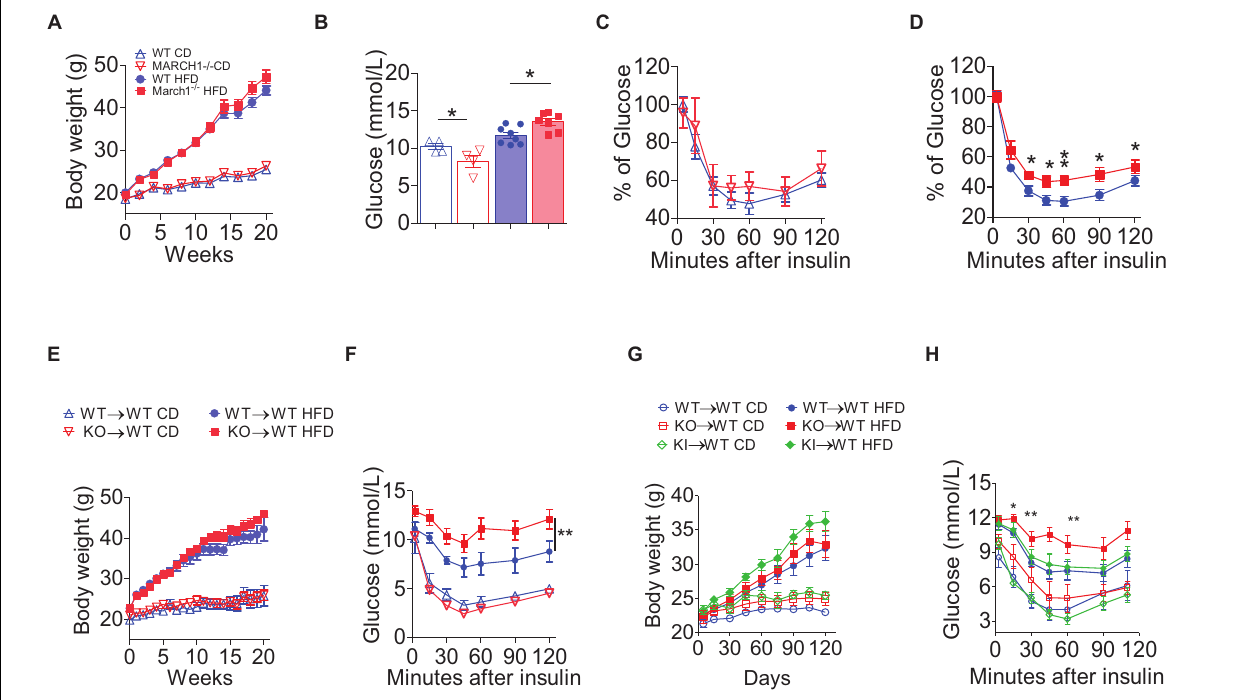
FIGURE 1 | March1 deficiency exacerbates obesity-induced insulin resistance. Mice were fed control diet (CD) or high-fat diet (HFD) and tested for fasting glucose and insulin tolerance (ITT). (A) Body weight gain, (B) fasting glucose, and (C,D) ITT of WT and March1 − / − mice after 20 weeks. (E–G) Six week old WT mice were lethally irradiated and received an i.v. injection of bone marrow cells from March1 − / − or WT mice. After 8 weeks of reconstitution, these WT BMC (WT → WT) and March1-/-BMC (KO → WT) were fed CD or HFD for 20 weeks. (E) Body weight gain and (F) ITT performed on body weight-matched mice. Experiment was repeated twice. In another independent experiment, MHCII KI BMC (KI → WT) were included. Body weight gain was measured during 16 weeks of feeding (G) and body weight-matched mice were submitted to an ITT (H) . ∗ P < 0.05 and ∗∗ P <